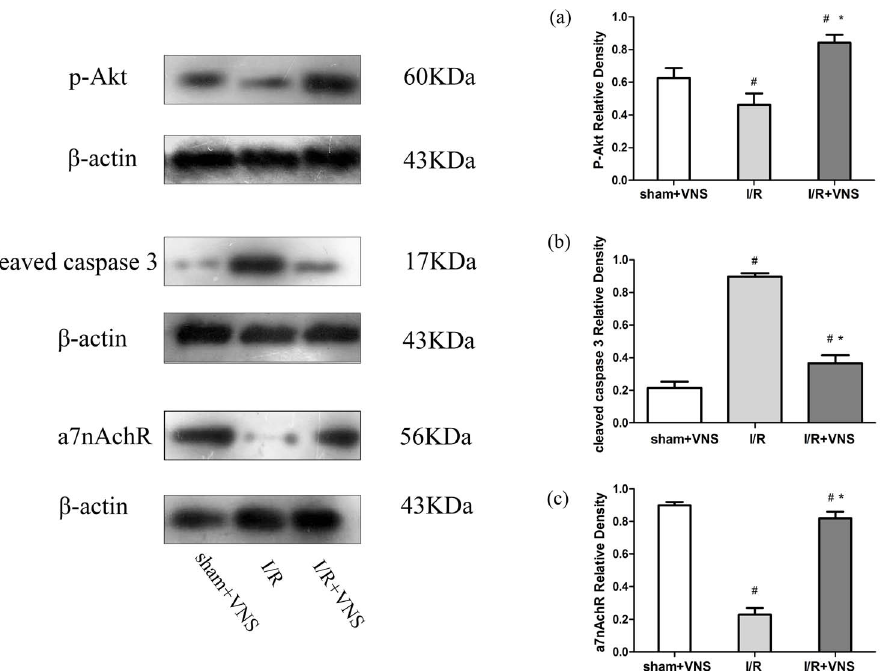
Figure 10. Expression of a7nAchR, P-Akt, and cleaved caspase 3 protein in the ischemic penumbra. Western blot showing the differential protein expression of a7nAchR, P-Akt, and cleaved caspase-3 24 h following reperfusion in the ischemic penumbra of rats among the three groups. b -actin is a loading control, showing equal loading of protein. A: sham + VNS group; B: I/R group; C: I/R + VNS group. (A) The density of a- 7nAchR, (B) p-Akt, and (C) cleaved caspase 3 protein expression normalized to b -actin protein expression. *P , 0.05 relative to the I/R group, # p , 0.05 relative to the sham + VNS group, n=8/group.